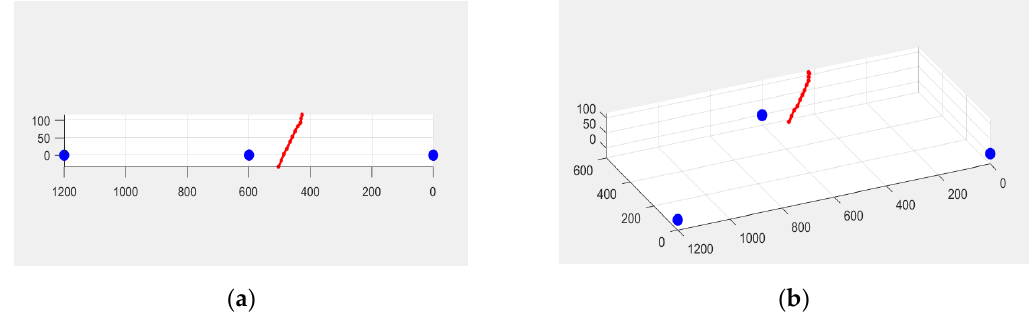
Figure 7. ( a ) Front view of the track; ( b ) 3D trajectory diagram.